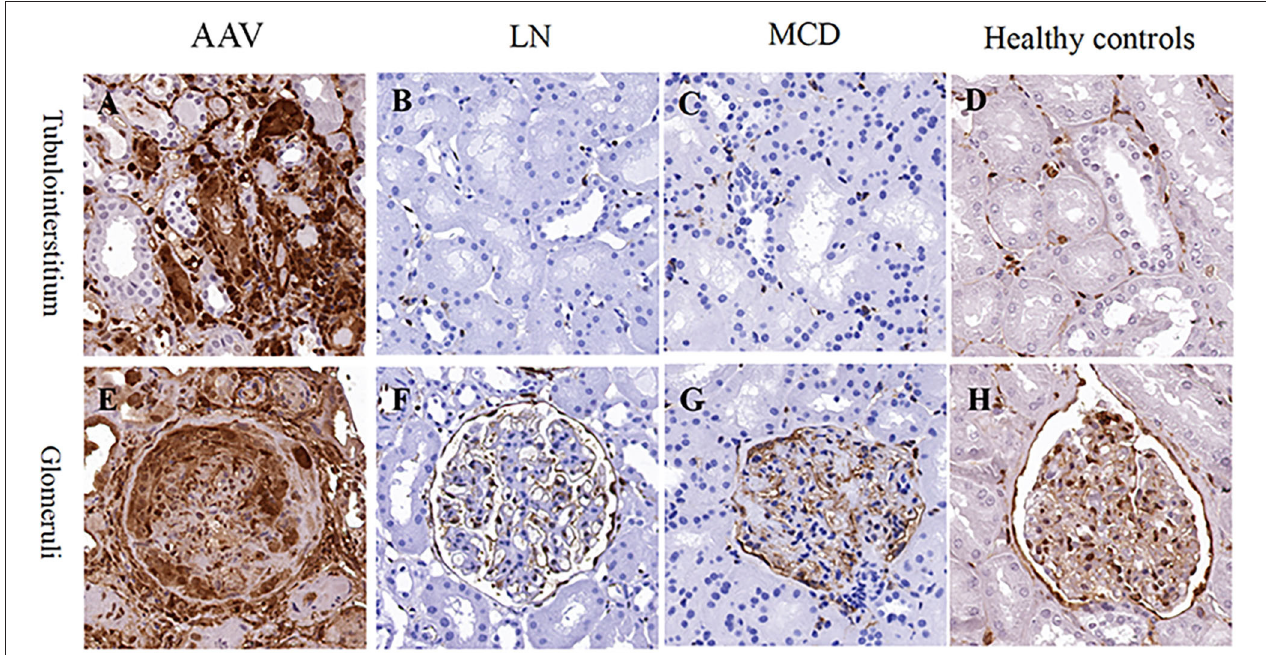
FIGURE 3 | Immunohistochemistry staining for ANXA1 in tubulointerstitium (A–D) and glomeruli (E–H) in patients with AAV (A,E) , LN (B,F) and MCD (C,G) as well as healthy controls (D,H) , respectively. AAV, anti-neutrophil cytoplasmic antibody (ANCA)-associated vasculitis; ANXA1, annexin A1; LN, lupus nephritis; MCD, minimal change disease.